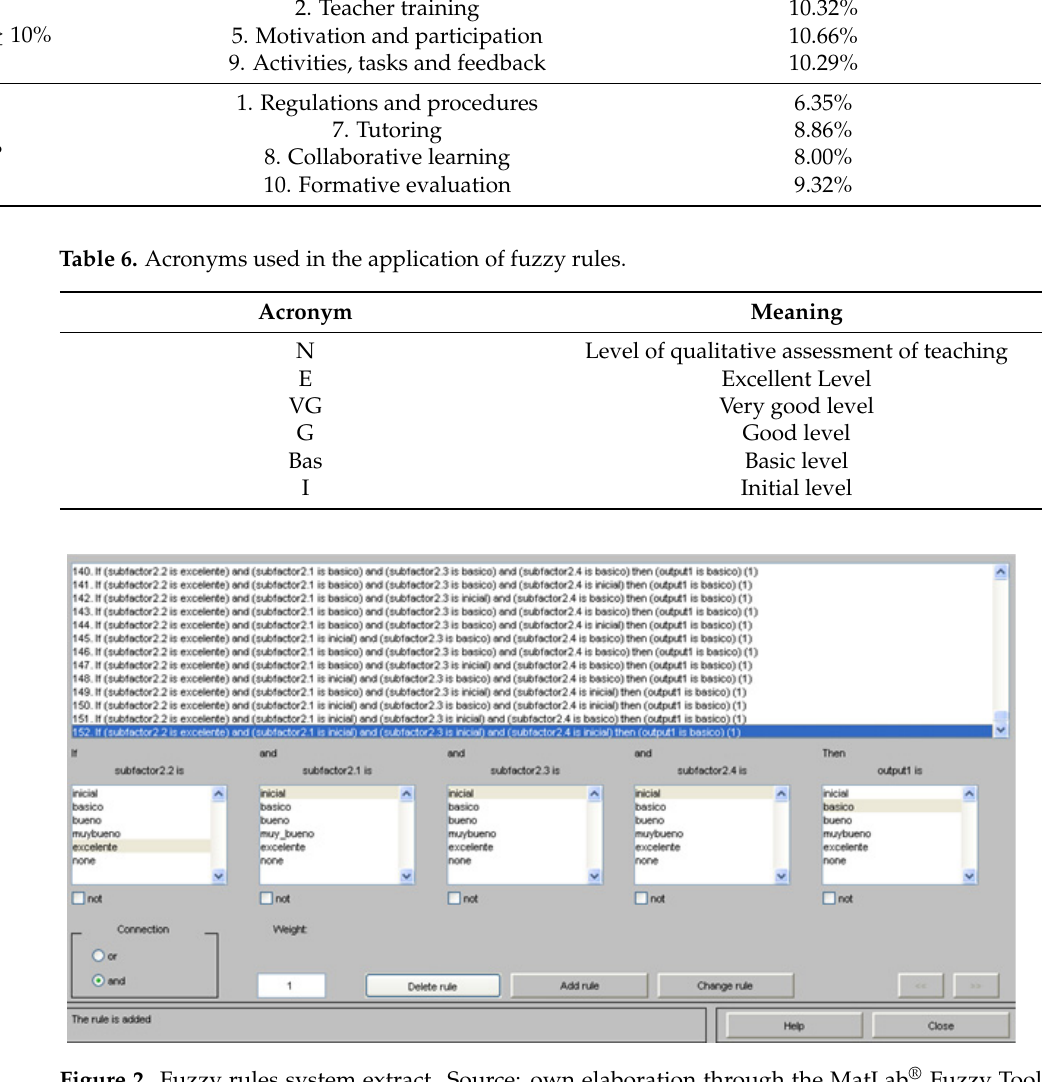
Table 6. Acronyms used in the application of fuzzy rules.